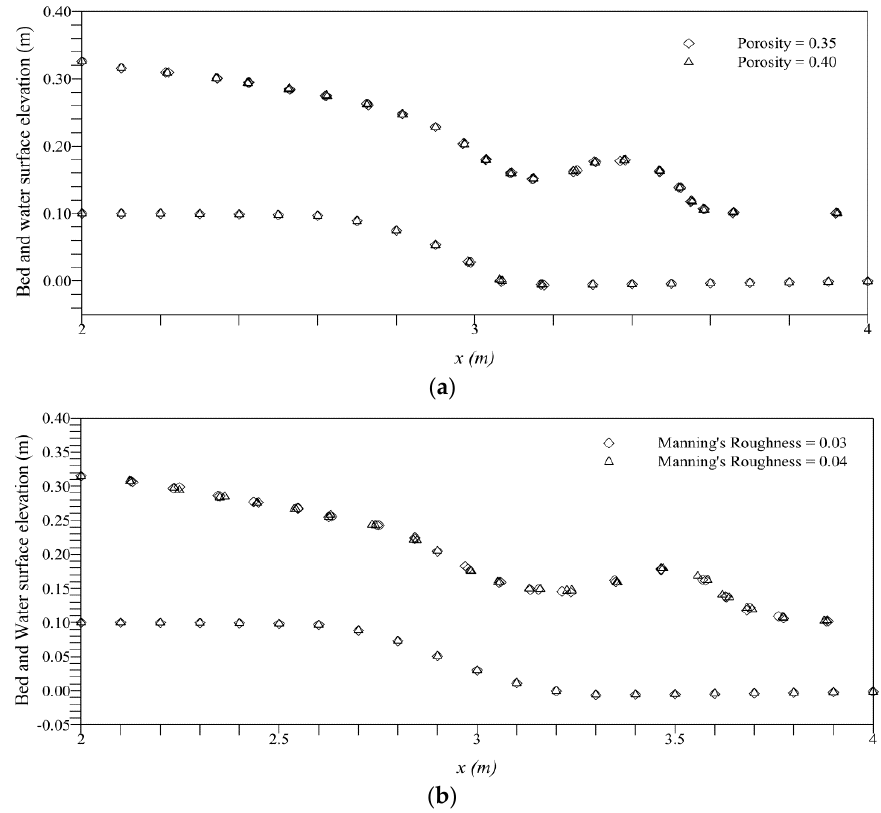
Figure 10. Sensitivity analysis for Configuration 4 to model parameters at t = 0.75 s: ( a ) porosity p; and ( b ) Manning’s roughness n.